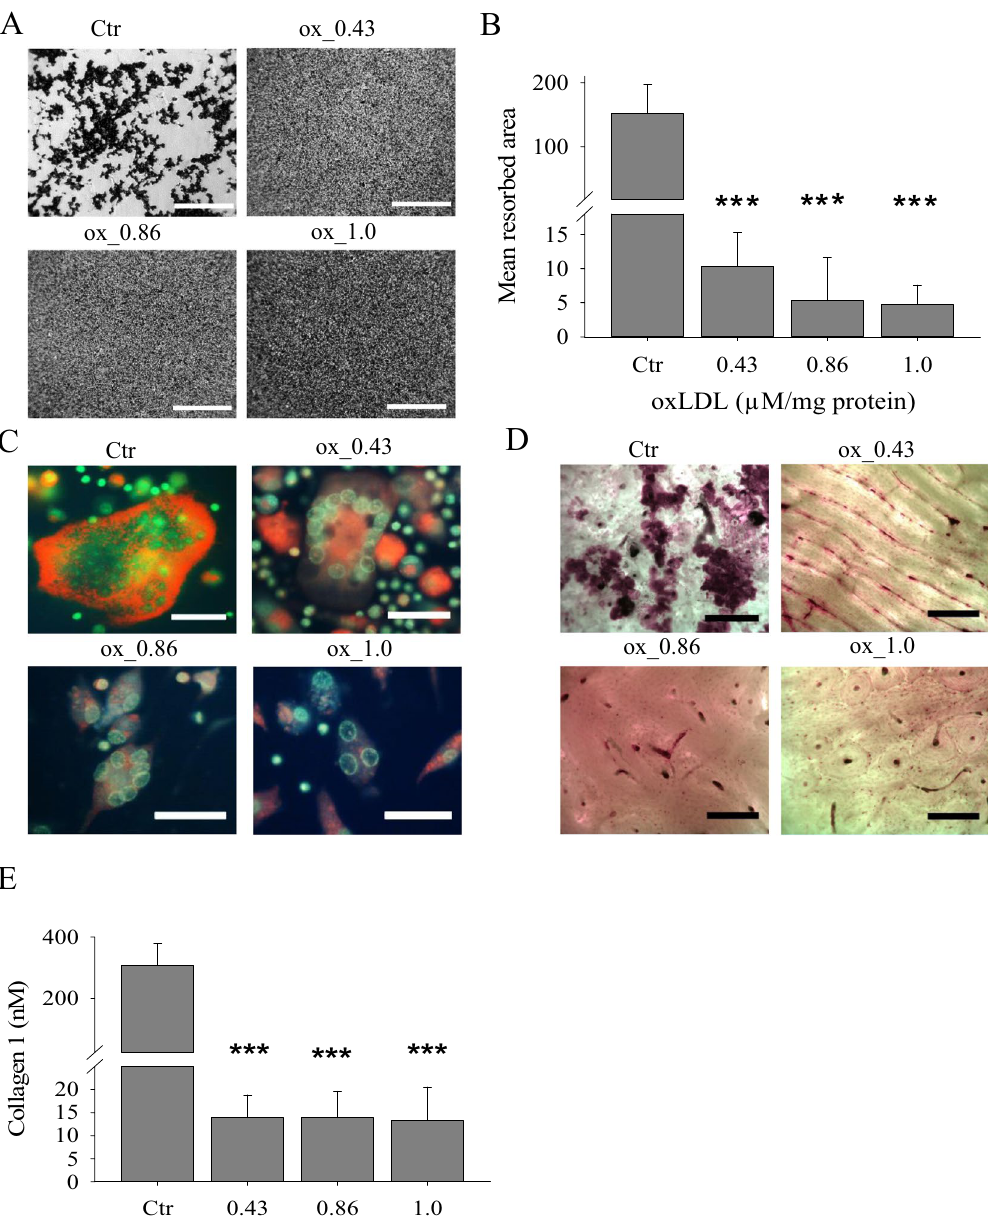
Figure 3. oxLDL blocks the functional activities of osteoclasts. Monocytes were plated on hydroxyapatite coated plates and bone slices for a total of 21 days. ( A ) Hydroxyapatite coated plates showing a total resorptive inhibition in the presence of oxLDL. Magnification x10, scale bar 1 mm. ( B ) Quantification of resorbed areas on hydroxyapatite coated plates with ImageJ. ( C ) Fluorescence microscopy of acridine orange staining of mature osteoclasts cultured on tissue culture plates showing v-ATPase mediated acidification. Green and orange indicate neutral and acidic pH respectively. Magnification x40, scale bar 1 mm ( D ) oxLDL inhibits resorptive activity of osteoclasts on bone slices. Magnification x10, scale bar 1.5 mm. ( E ) Conditioned media from D was collected and analyzed for the presence of collagen type 1 fragment using a colorimetric ELISA method. n ≥